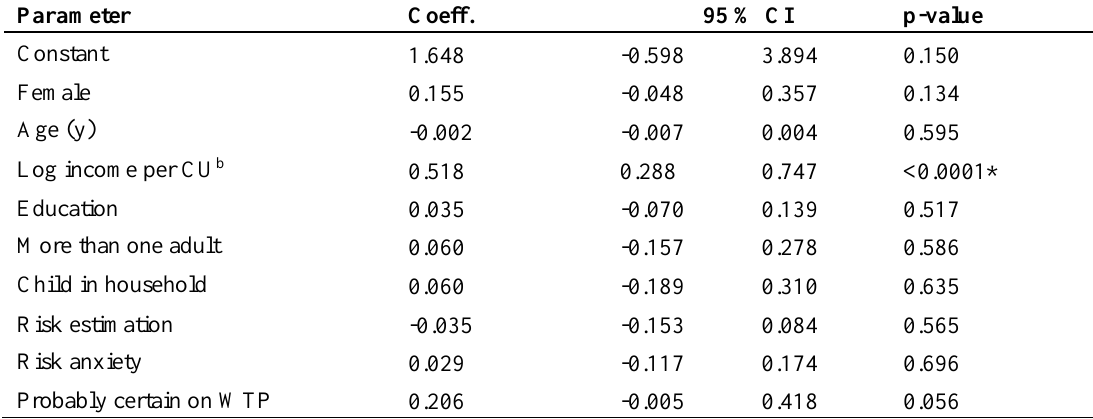
Regression of log willingness-to-pay (WTP) for the base case sample a Parameter Coeff. 95 % CI p-value